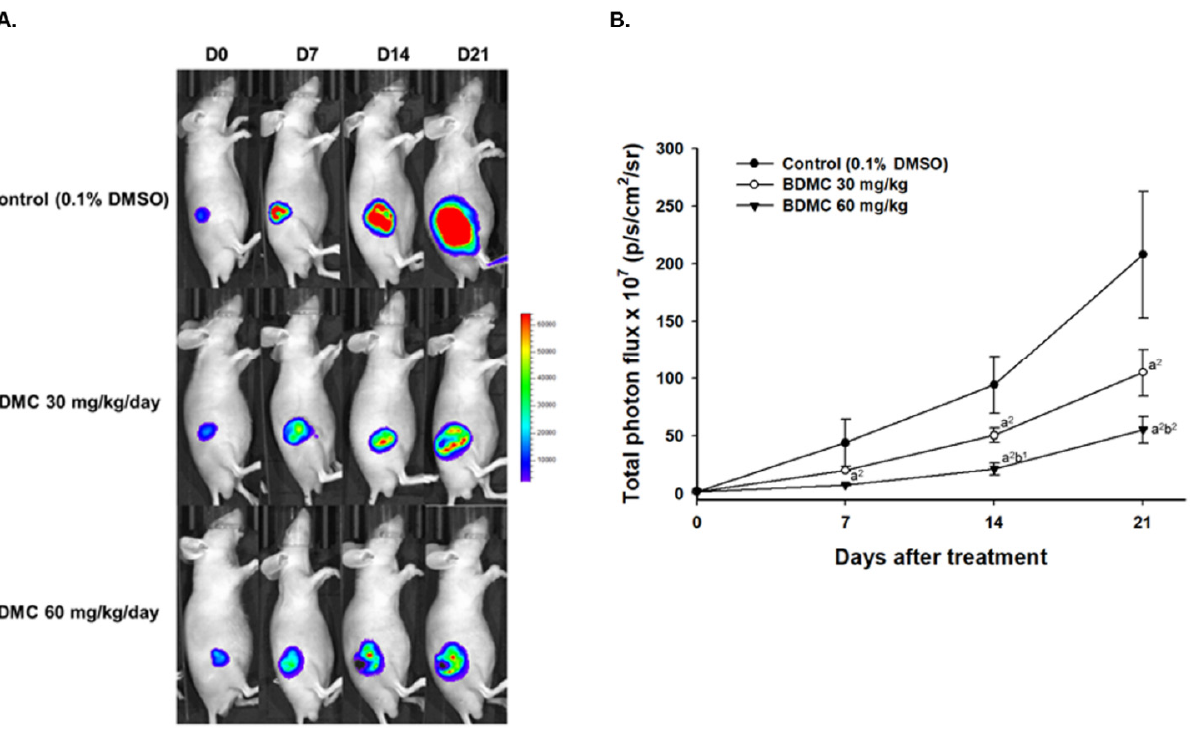
Figure 5. Luc2 signals from living tumor cells were suppressed by BDMC treatment. ( A ) The representative BLI results from each group at different time points. ( B ) Quantification results of luc2 signal intensity of tumors. (a 2 p < 0.01 vs. control; b 1 p < 0.05 and b 2 p < 0.01 vs. BDMC 30 mg/kg).